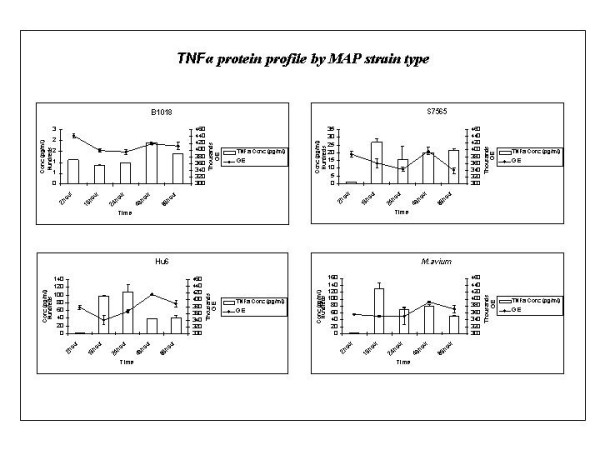
TNFα protein secreted by MDM cells exposed to MAP over time was measured by ELISA. Total amount of protein (pg/ml) is plotted on Y-axis (note that the Y1-axis scales have been optimized for magnitude of TNFα expression for each strain). Intracellular bacterial numbers were calculated based on the genome size of MAP and represented as genome equivalents (GE) on second Y-axis. MDMs stimulated with B1018 secreted low amounts of TNFα protein relative to other cell stimulations.